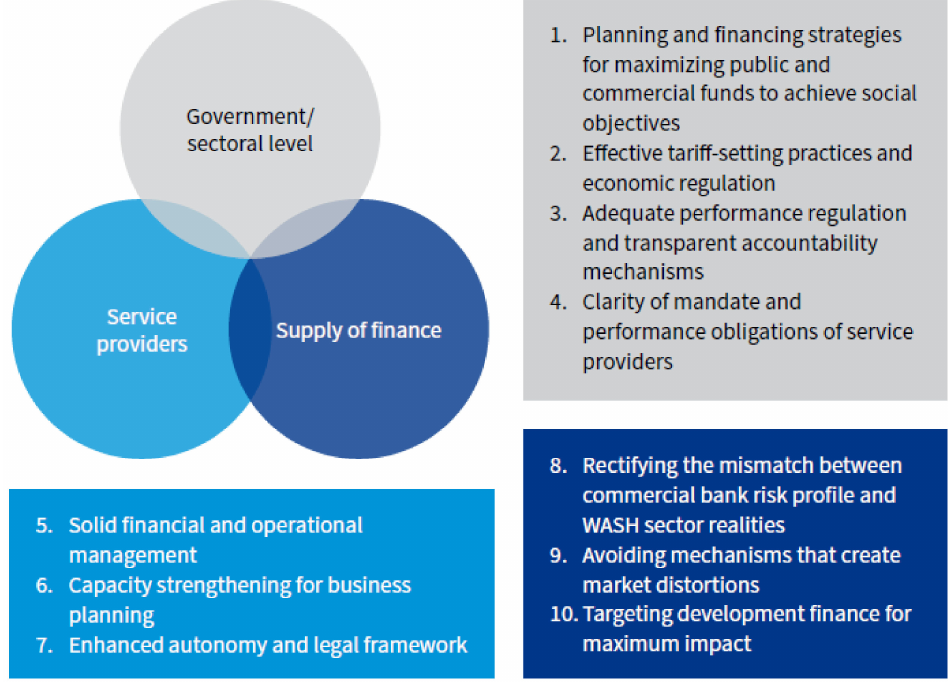
Figure 2. Ten foundational issues to mobilise finance for WASH grouped by stakeholder